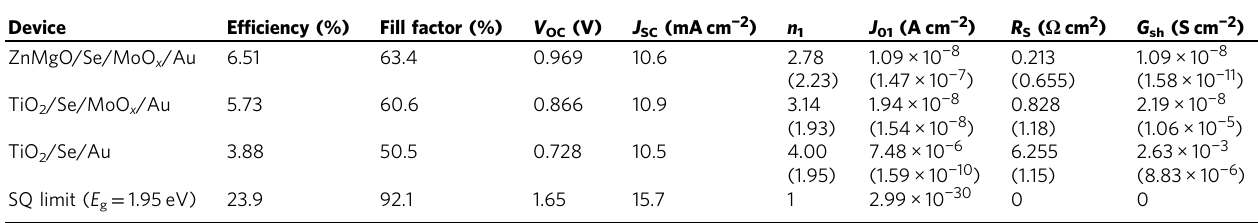
Table 1 Top performing Se devices